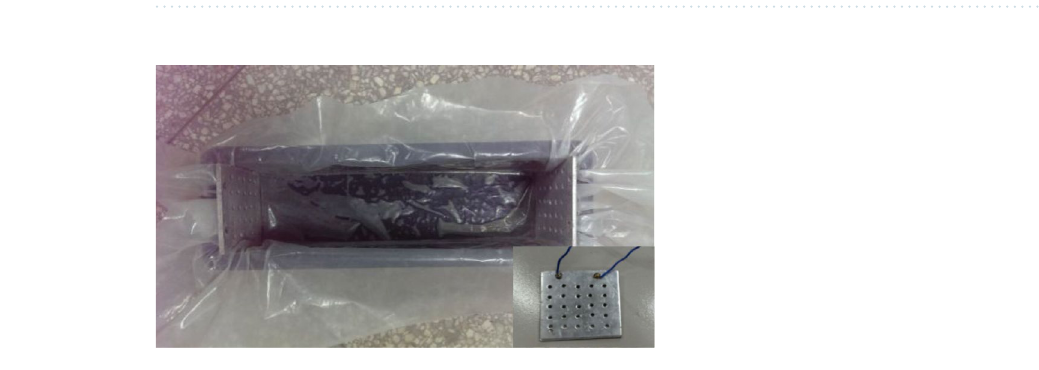
Figure 2. Test using a plastic film and the electrode.